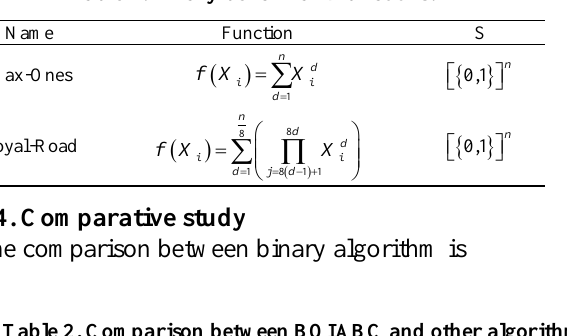
Table 2. Comparison between BQIABC and other algorithms using the knapsack problems with 50, 200, and 400 items. Items